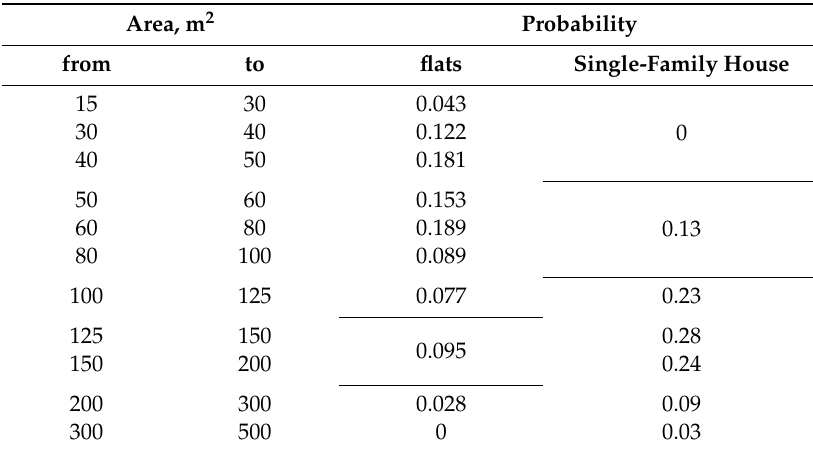
Table 4. Structure of the surface of single-family houses and apartments in multi-apartment buildings in Poland. Source: own study based on